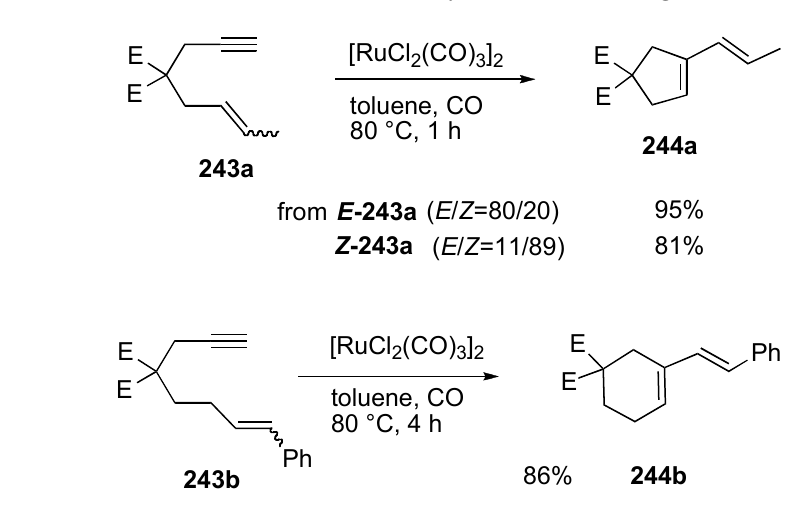
Scheme 66. Trapping of carbenoid